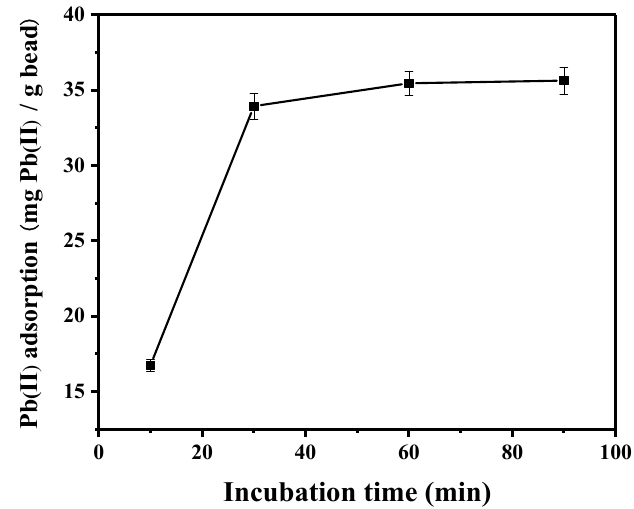
Figure 2. E ff ect of contact time on Pb(II) adsorption onto peptide-linked bead. Figure 2. Effect of contact time on Pb(II) adsorption onto peptide-linked bead.